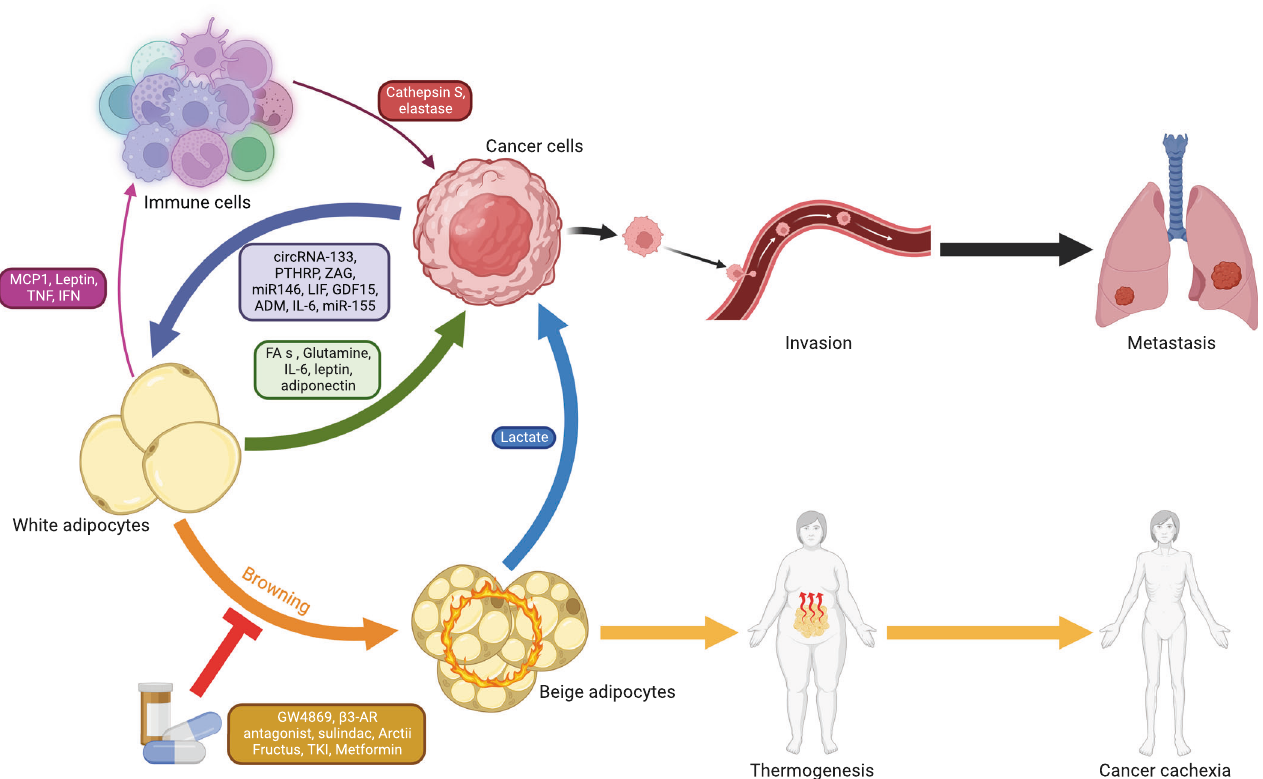
Fig. 3 The role of thermogenic adipose tissue in malignancy. Polypeptides, metabolites, or other certain mediators derived from cancerous cells initial the conversion of white-to-beige locally and distantly. On the one hand, activated beige adipocytes in SAT lead to lipolysis and energy expenditure, subsequently contributing to cancer-associated cachexia. On the other hand, the adjacent thermogenic fat can directly promote tumor growth and metastasis by secreting speci fi c molecules, such as lactate. Accordingly, pharmacologically inhibiting the browning of white adipose tissue slows cancer progression and improves the outcomes for patients. ZAG zinc- α 2 -glycoprotein, PTHRP parathyroid-hormone-related protein, LIF leukemia inhibitory factor, GDF15 growth differentiation factor 15, ADM adrenomedullin, IL-6 the cytokine interleukin-6, β 3-AR β 3-adrenergic receptor, TKI tyrosine kinase inhibitor, Arctii Fructus the extract of Arctium lappa. This fi gure was created on BioRender.com with permission for